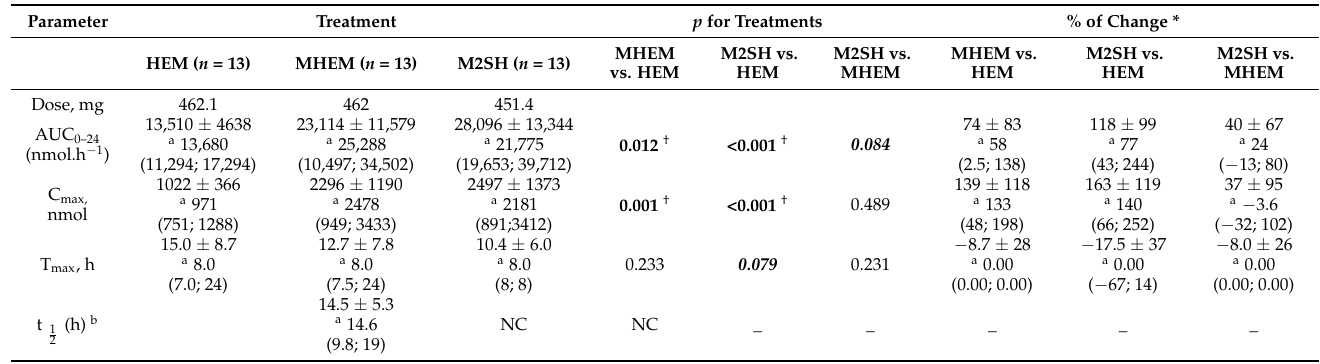
Table 3. Non-compartmental single-dose kinetics of Hesperidin metabolites plus Hesperidin catabo- lites after Hesperidin epimeric mixture (HEM), micronized Hesperidin epimeric mixture (MHEM) and micronized 2S-Hesperidin (M2SH) treatments.